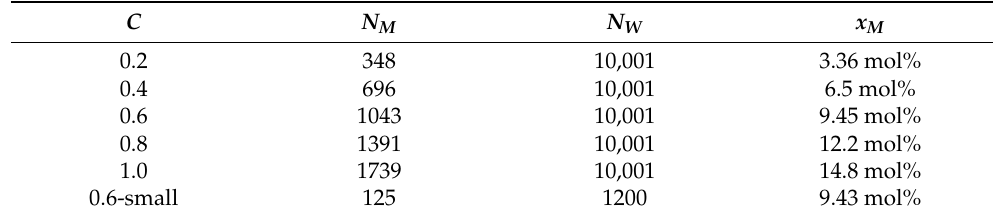
Table 1. Designation of concentration, C , for methane ( N M ) + water ( N W ) solution compositions and correspondence to molar concentration ( x M